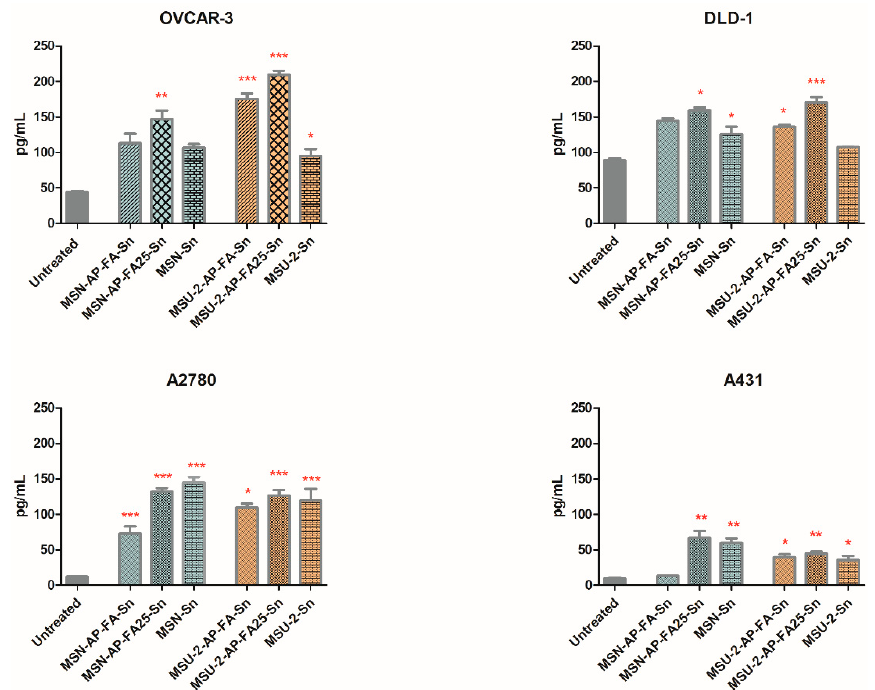
Figure 9. Concentration of FOLR1 secreted by tumour cells subjected to treatment with tin-containing mesoporous compounds. In the upper row the folate-receptor-positive OVCAR-3 and DLD-1 cells, in the lower row are the A2780 and A431 cells, with low folate receptor expression. Statistically significant changes in FOLR1 level vs. the untreated reference are evidenced by starring: * represents p < 0.05, ** p < 0.01 while *** p < 0.001. The columns with magenta borders represent the materials functionalized with 10% FA, and the blue border represents the materials functionalized with 25% FA.